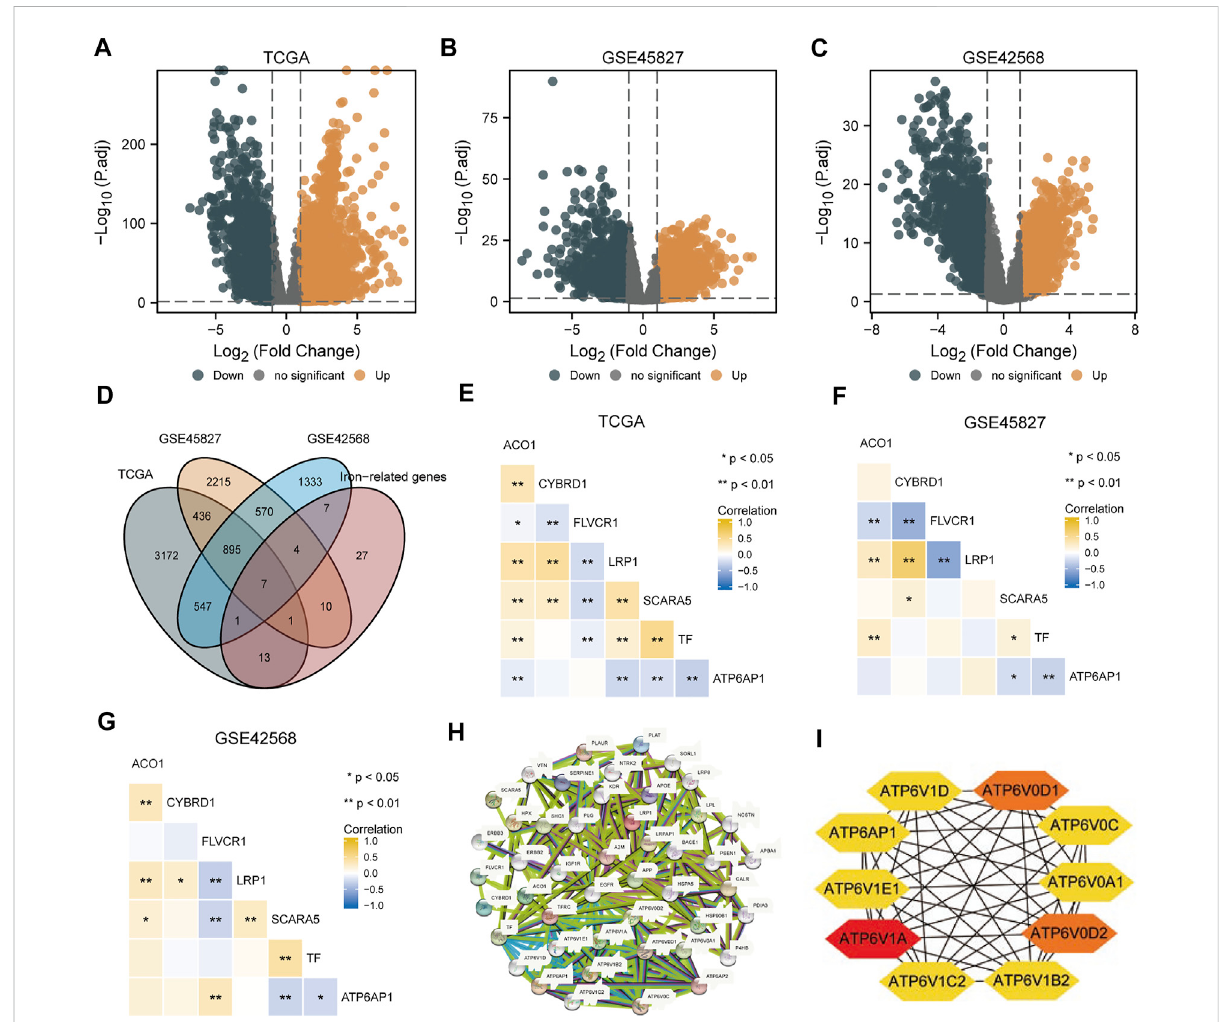
FIGURE 1 DEGanalysesofthreedatasets. (A) TCGA-BRCAdataset ’ svolcanomapshowsdifferentiallyexpressedgenes. (B) TheGSE45827datasetshowsa volcano map of genes with differential expression. (C) The GSE42568 dataset shows a volcano map of differentially expressed genes. (D) Venn diagram of differential expressed genes in three datasets and iron metabolism-associated genes. (E – G) Heat maps of correlation among seven iron metabolism-related genes in the TCGA-BRCA, GSE45827, and GSE42568 datasets. (H) A PPI network was constructed by differentially expressed genes and iron metabolism-associated genes. (I) Top 10 hub genes extracted by